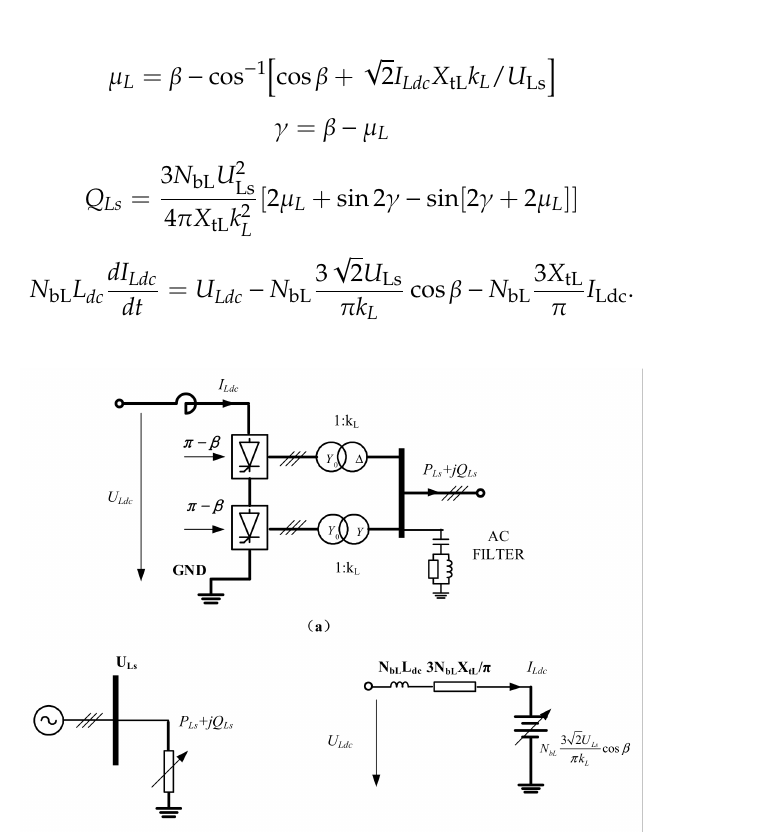
Figure 3. Equivalent circuit diagram of the LCC. ( a ) A 12-pulse converter. ( b ) The AC side equivalent circuit diagram. ( c ) The DC side equivalent circuit